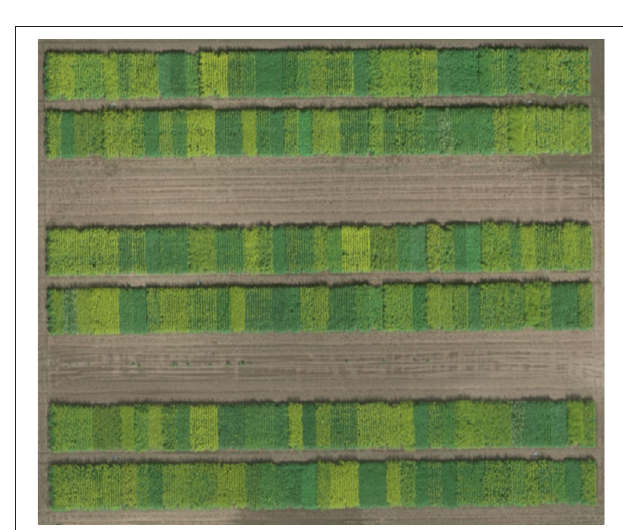
FIGURE 1 | The overview of experimental plot layout at the Agriculture and Agri-Food Canada Research Farm (52 ◦ 10’ 52.9” N, 106 ◦ 30’ 10.6” W) near Saskatoon, SK, Canada on July 14,